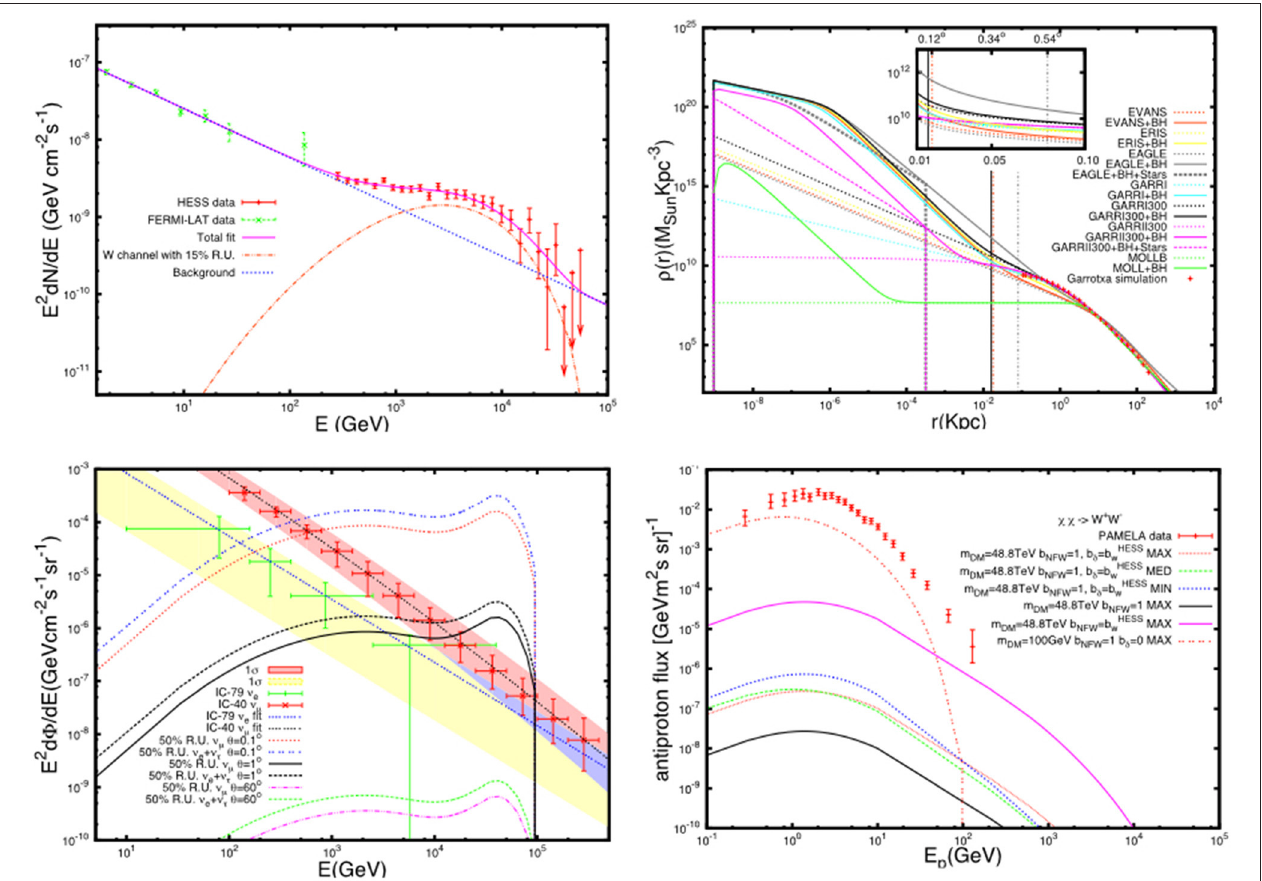
FIGURE 1 | Upper Left : Figure from Gammaldi (2016b). The combination of the gamma-ray flux expected by DM annihilation events with a power-law background component well fits the gamma-ray spectra of Fermi-LAT and HESS data with a thermal DM particle of mass of 48.8 TeV that annihilates in the W + W − boson channel ( Cembranos et al., 2012b, 2013b). Upper Right : Figure from Gammaldi et al. (2016). The enhancement of 10 3 required in order to fit the gamma-ray spectra can be explained by the J-factor of a BH-induced DM-spike in hydrodynamical N-body simulations with a cusp profile. Lower Left : Figure from Cembranos et al. (2014) . The expected neutrino flux from 48.8 TeV DM candidate is compared with the atmospheric neutrino background detected by IceCube. Lower Right : Figure from Cembranos et al. (2015). the expected antiproton flux from 48.8 TeV DM candidate is compared with the PAMELA data. The total antiproton flux considers the diffusion of antiprotons produced by multi-TeV DM in the halo and the extra component given by the DM-spike at the